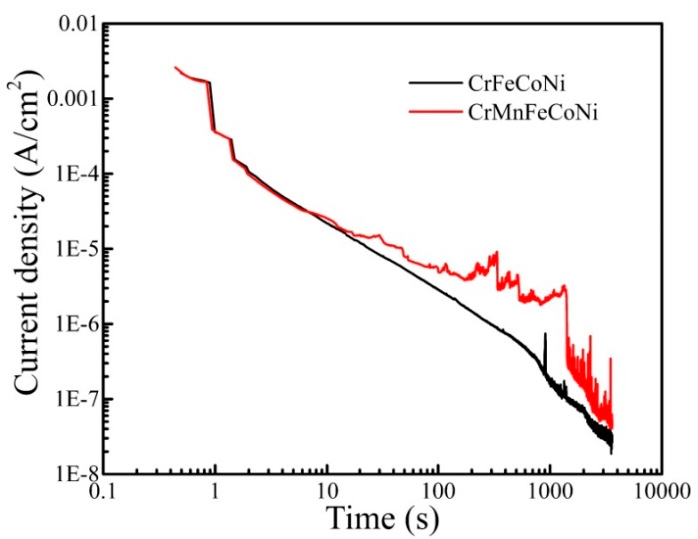
Figure 8. Logi-logt plots for the CrFeCoNi and CrMnFeCoNi coatings at applied voltage of 0.1 V SCE in 3.5 wt% NaCl solution.